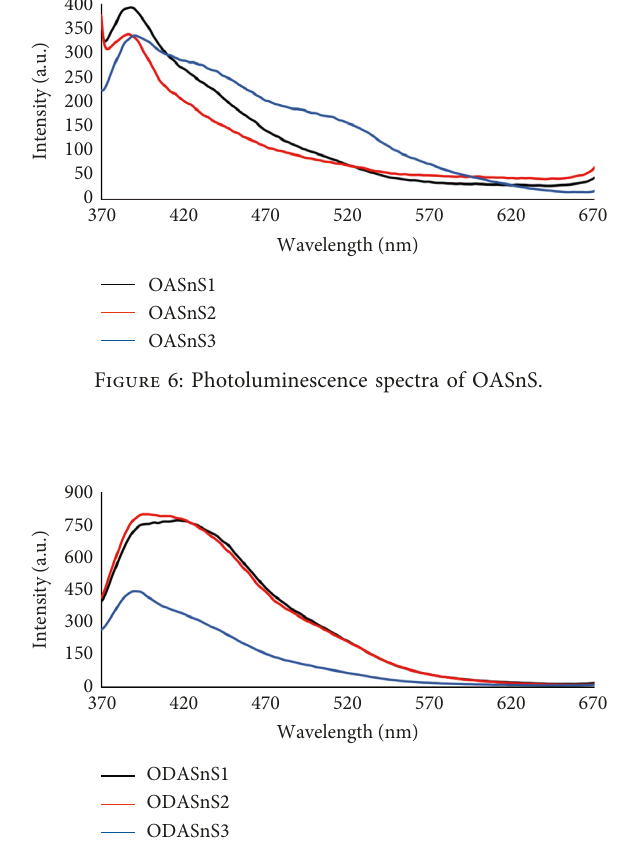
Figure 7: Photoluminescence spectra of ODASnS.